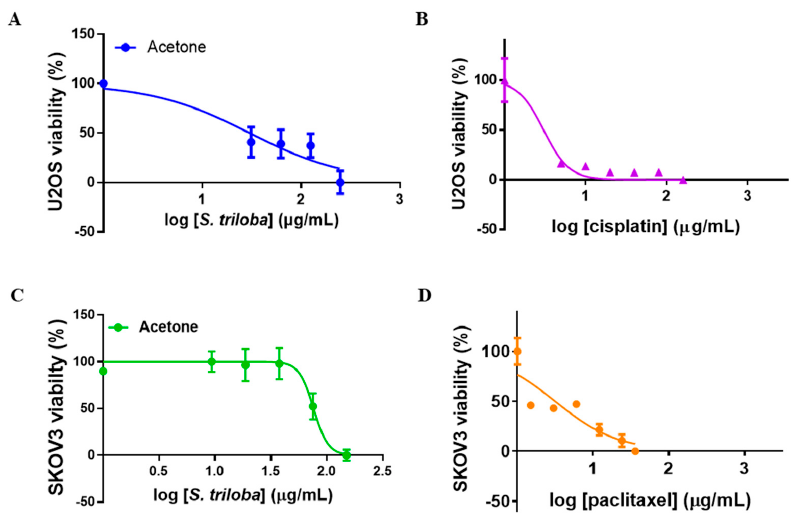
cells treated with S. triloba acetone extract (Table S1).